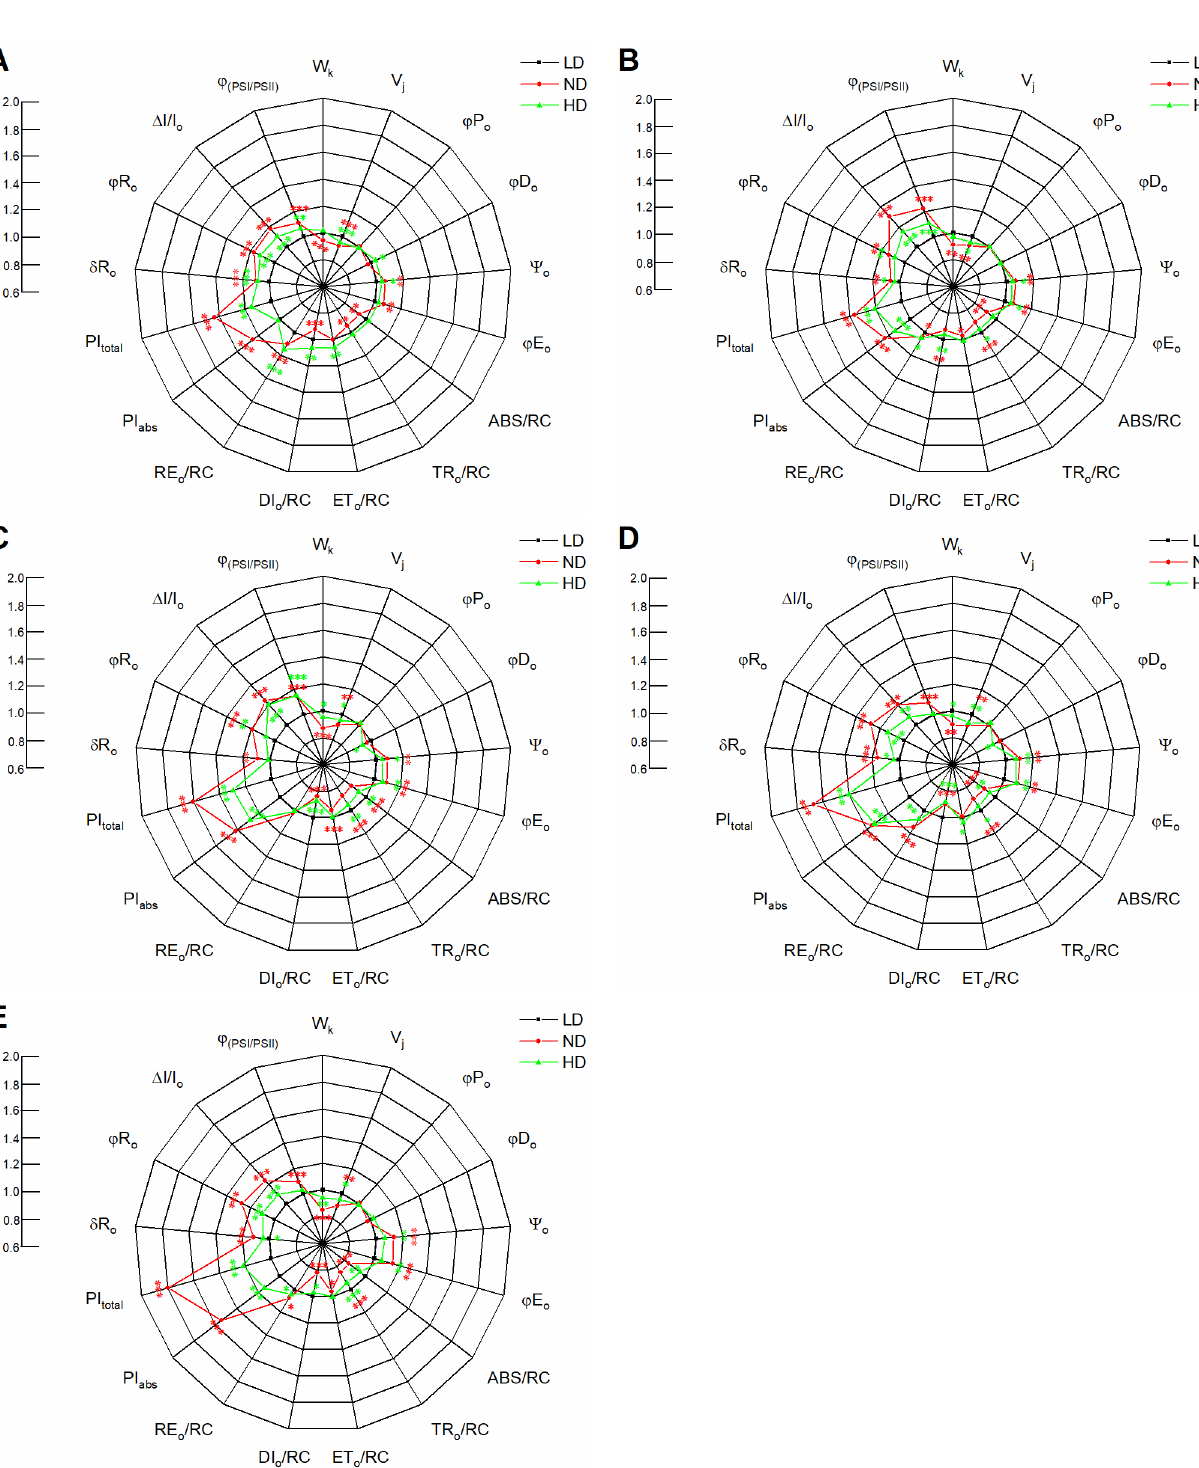
Figure 5. Spider plots showing changes in JIP-test parameters in maize leaves planted in low density (LD), normal density (ND), and high density (HD) and measured at 0 ( A ), 10 ( B ), 20 ( C ), 30 ( D ), and 40 d ( E ) after anthesis. Values are means ( n = 9). Asterisks (*, **, and ***) denote significant differences between different planting densities according to Fisher’s LSD test at p ≤ 0.05, p ≤ 0.01, and p ≤ 0.001, respectively. Significant differences between low and normal (red) or high (green) density treatment are denoted by asterisks of different colors.